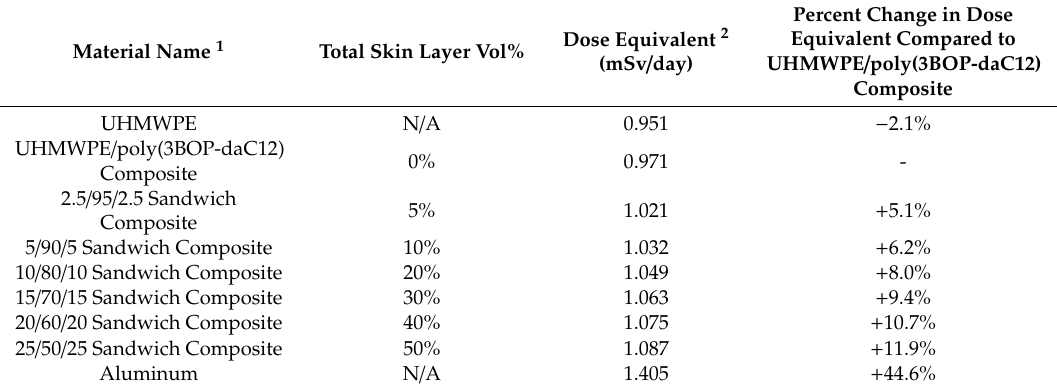
Table 5. Comparison of On-Line Tool for the Assessment of Radiation in Space (OLTARIS) simulation results.